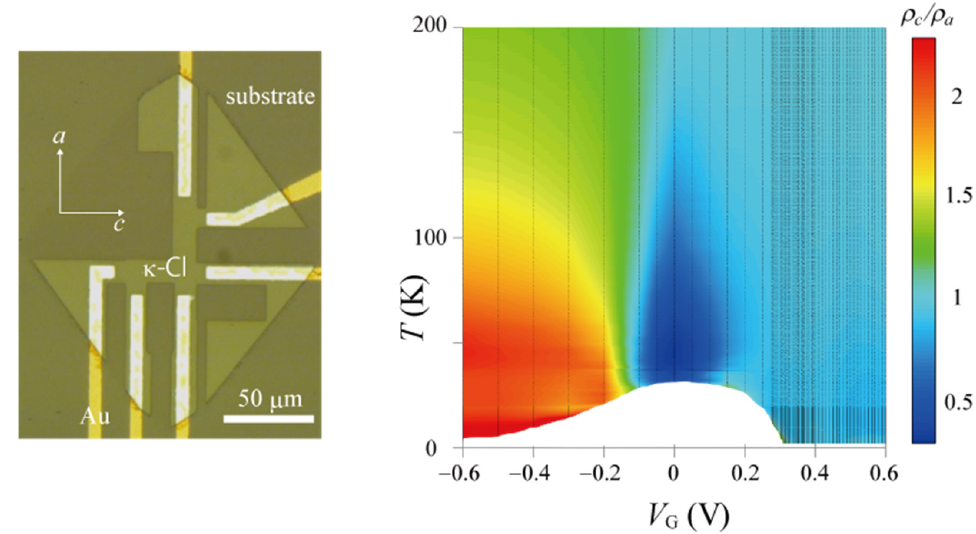
Figure 11. Temperature dependence of in-plane anisotropy of surface resistivity (note that both a and c axes are parallel to the conducting plane in this material). Data are missing at low temperatures and low doping (white region in the right panel) due to the high resistance.